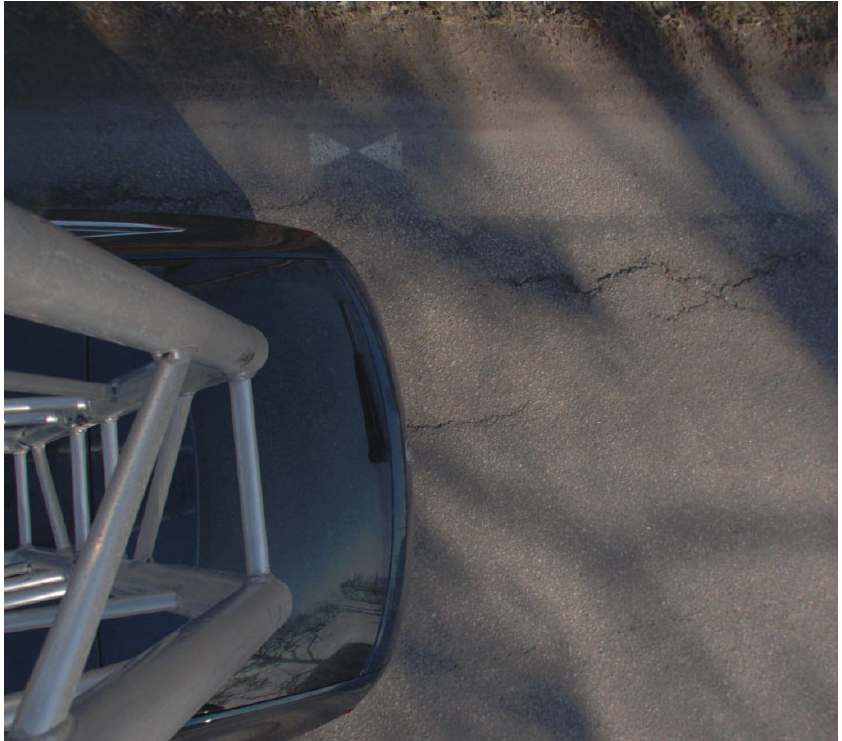
Figure 2. Ground target painted on the pavement. The location for the target was measured to the center between the two triangles.